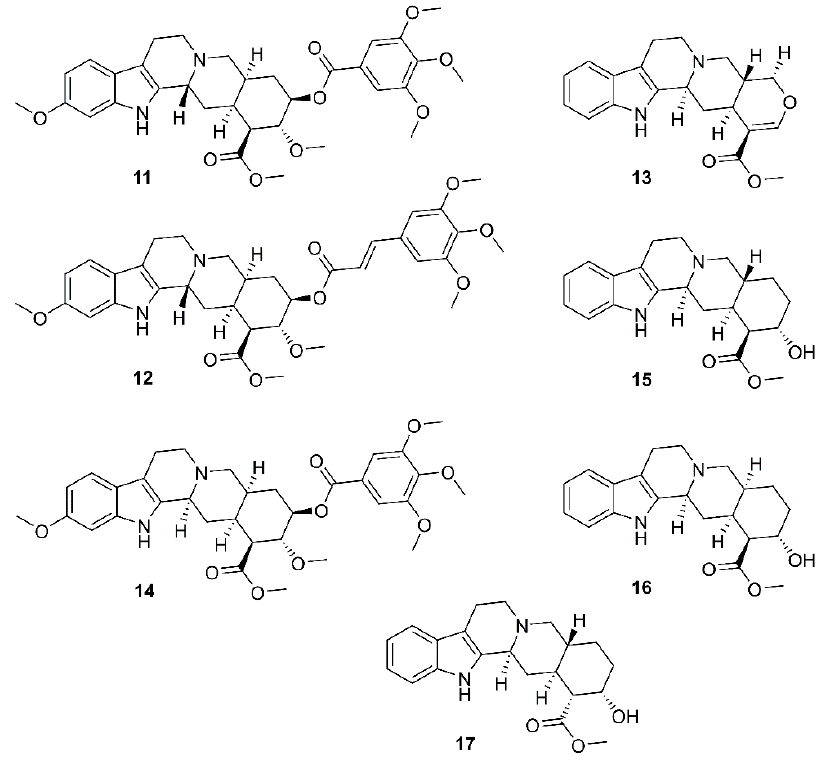
Figure 4. Structures of reserpine ( 11 ) and its analogs 12 – 17